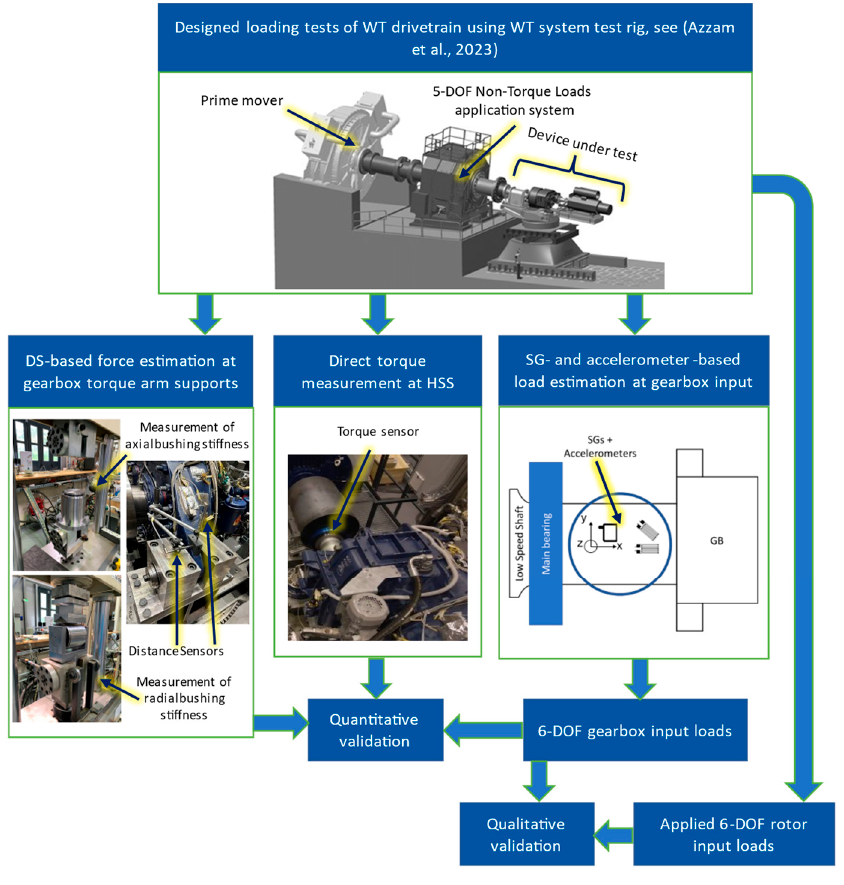
Figure 1. Overview of methodology [29].